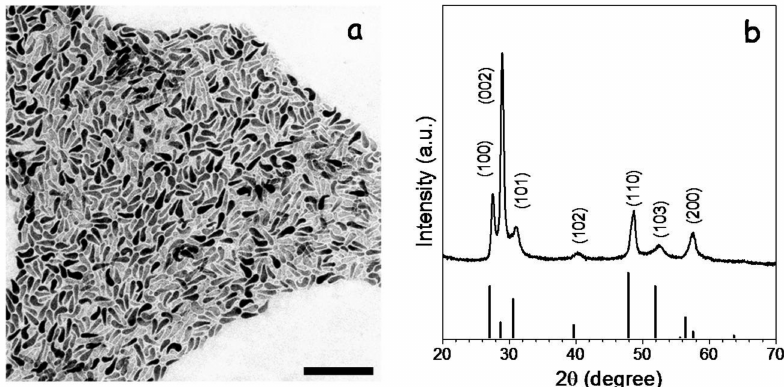
Figure 1. Representative TEM micrograph ( a ) and XRD pattern ( b ) of CGS NCs with wurtzite crystal phase. TEM scale bar = 200 nm. The JCPDS (Joint Committee on Powder Diffraction Standards) 001-1280 phase standard card, corresponding to wurtzite CGS, is included as a reference